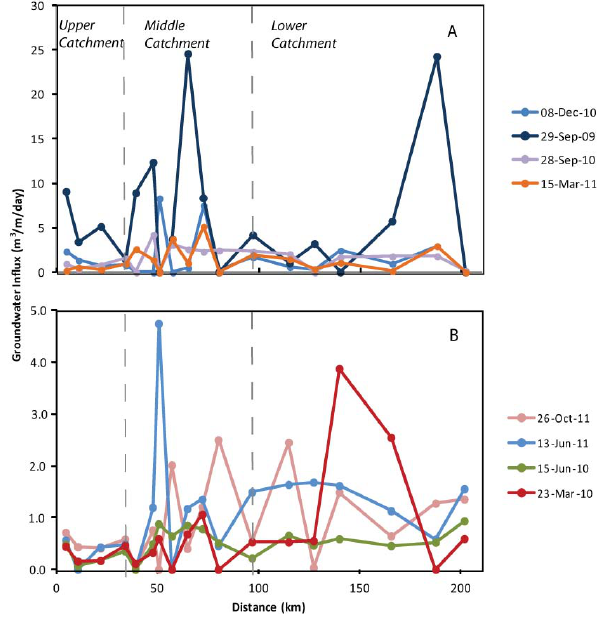
Fig. 7. Groundwater influxes calculated from 222 Rn activi- ties, based on high k values, in flow conditions of 4894 to 18520MLday − 1 (A) and of 995 to 2606MLday − 1 (B) . High base- flow occurs in the upper catchment and often increases during high flow conditions. High baseflow also occurs 65 to 72km and 166 to